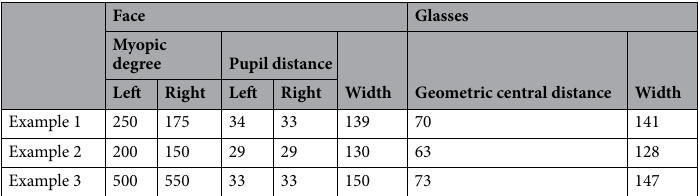
Table 4. Feature sizes of the example face and selected myopic glasses.